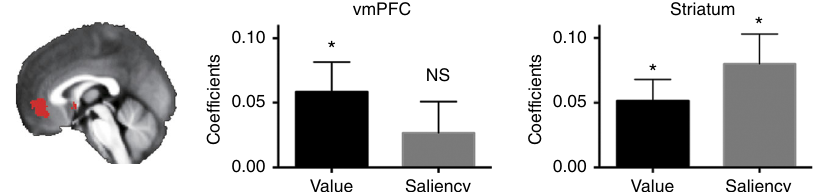
Fig. 4 Region-of-interest univariate analysis. Univariate value and saliency signals in the vmPFC and the ventral striatum, de fi ned based on a recent meta- analysis of the valuation system 20 . In the vmPFC, there was a signi fi cant effect of value, but not saliency, while in the ventral striatum, the effects of both value and saliency were statistically signi fi cant ( n = 18). Error bars denote SEM. NS not signi fi cant; + p < 0.1; * p < 0.05; *** p < 0.001. vmPFC